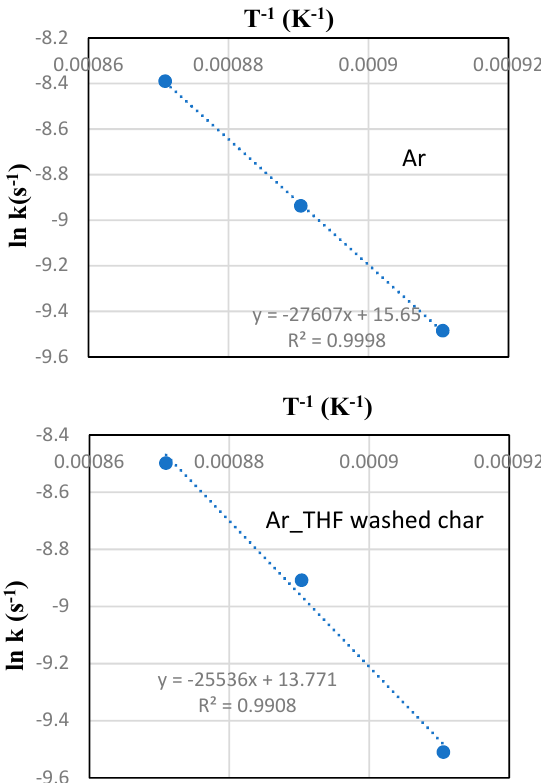
Figure 13. Arrhenius plots for chars generated in different gaseous atmospheres. Figure 13 . Arrhenius plots for chars generated in different gaseous atmospheres. Table 7. Kinetic parameters for the chars generated in various pyrolysis atmospheres (at 10% conversion).